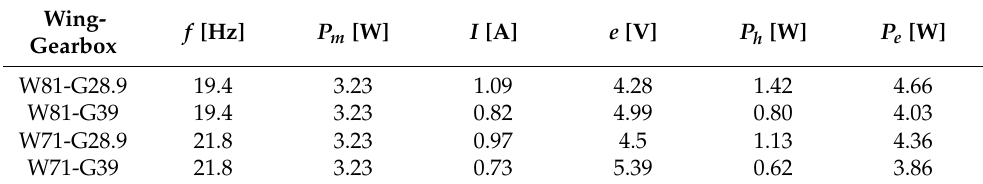
Table 5. Two batteries B2 in series and Motor M2: Influence of the wing size and the gearbox. Flapping frequency f , mechanical power P m , current I , voltage e , heat power P h and total electric power P e . The lift is L = 22.8 gr in all cases.